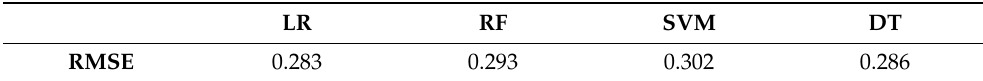
Table 9. Predictive models using forum grades as predictors to forecast grades from summative assessment